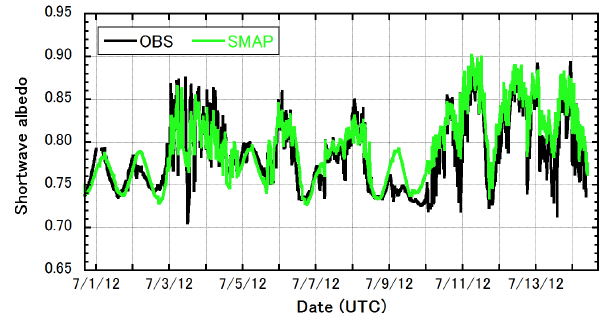
Figure 9. Shortwave albedos at the SIGMA-A site during the IOP observed with AWS and simulated by the SMAP